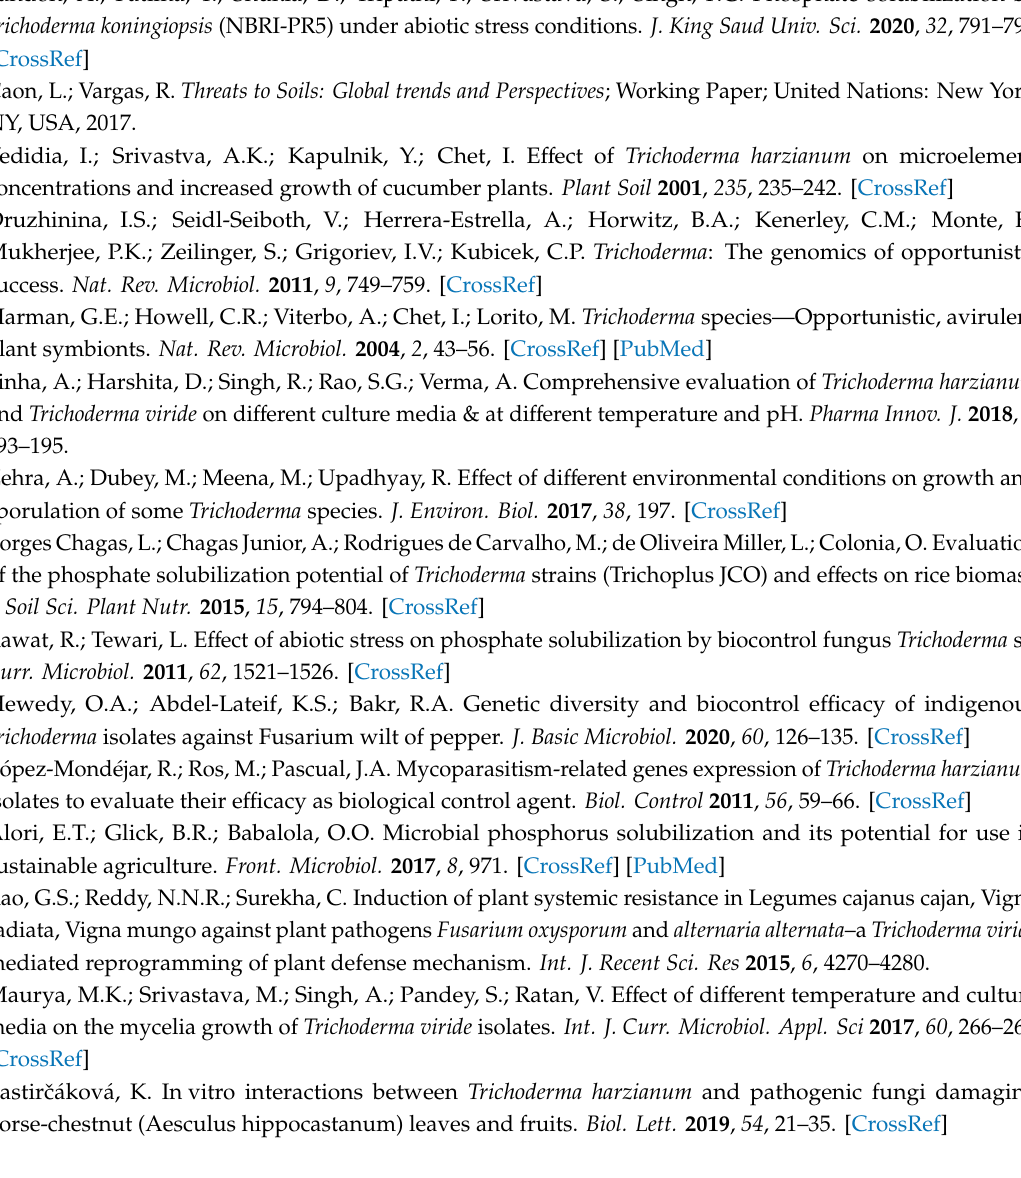
Figure S1: Competition of fungal pathogen F.g and Trichoderma strains, Table S1: Antagonistic activity of T. harzianum ( Th6 ) against F. graminearum under thermal